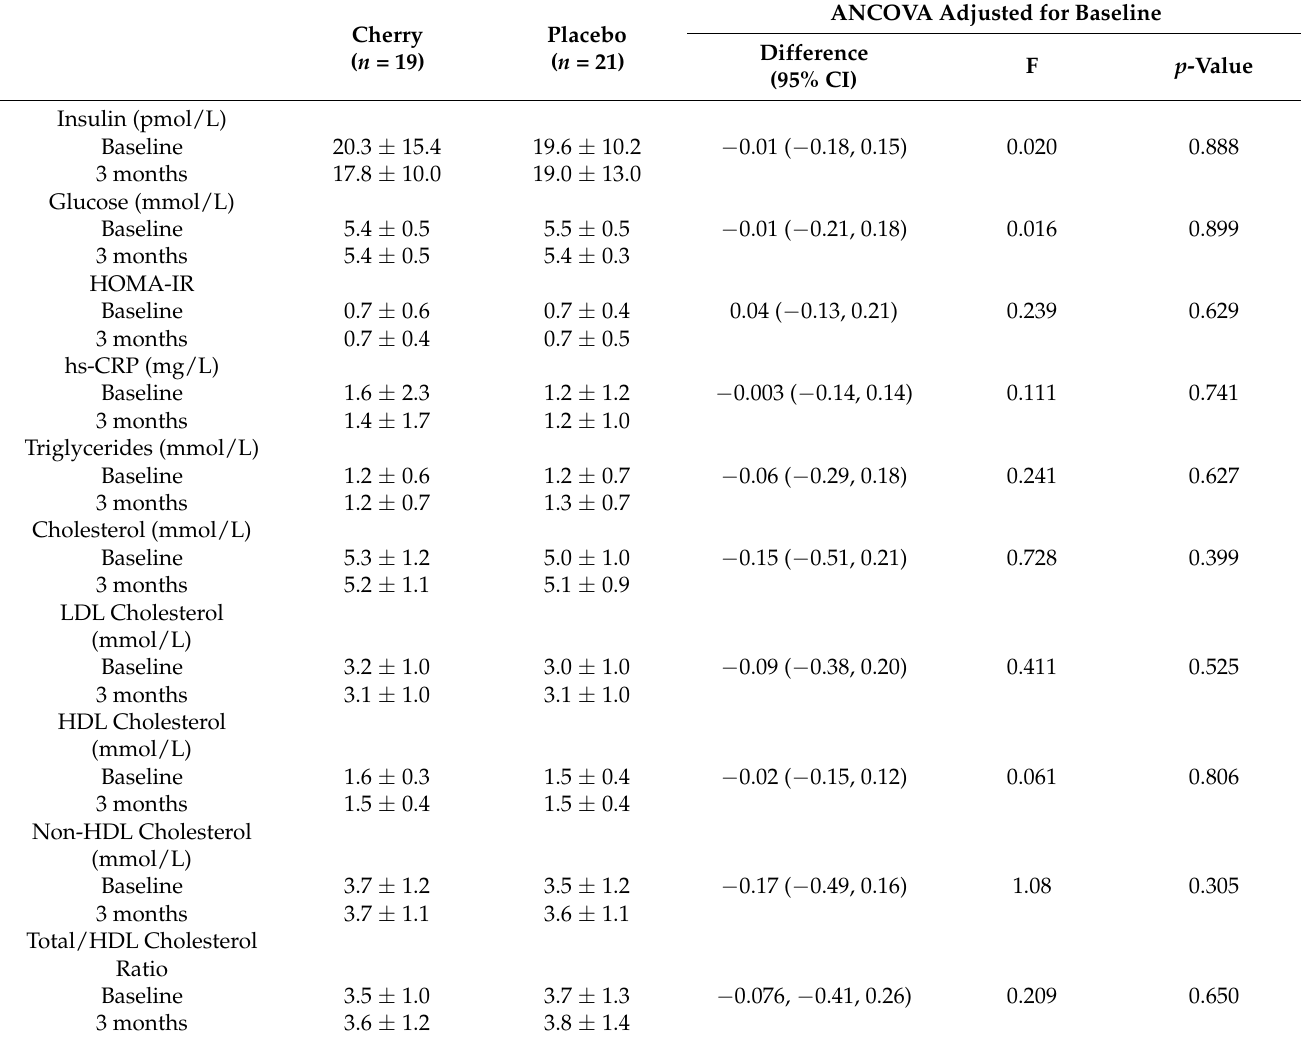
Table 4. Influence of tart Montmorency cherries on metabolic health